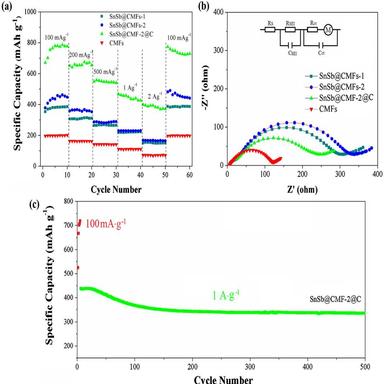
(a) Rate capabilities of SnSb@CMFs-1, SnSb@CMFs-2, SnSb@CMF-2@C, and CMFs at varying current densities, (b) electrochemical impedance spectroscopies of SnSb@CMFs-1, SnSb@CMFs-2, SnSb@CMF-2@C, and CMFs, and (c) cycling performance of SnSb@CMF-2@C at 100 mA∙g1 for the first five cycles and then 1 A∙g1 for following 500 cycles.